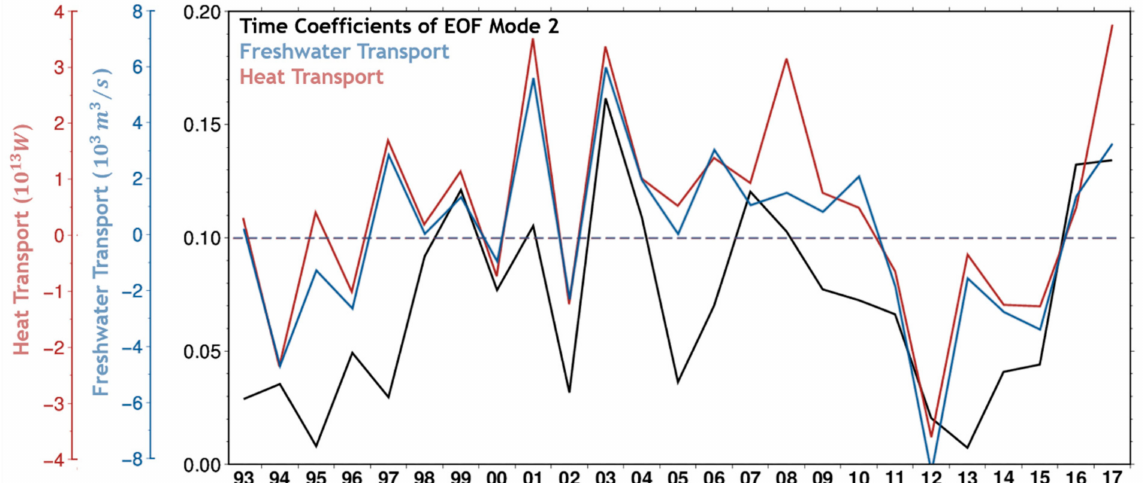
Figure 7. Time-series of temporal evolution of EOF mode 1 (black) for October–November–December (OND) when the mesoscale features are manifested in the NES, OND heat transport (red), and OND freshwater transport (blue) passing through 40 ◦ N, between 128 ◦ E and 130 ◦ E (green line in Figure